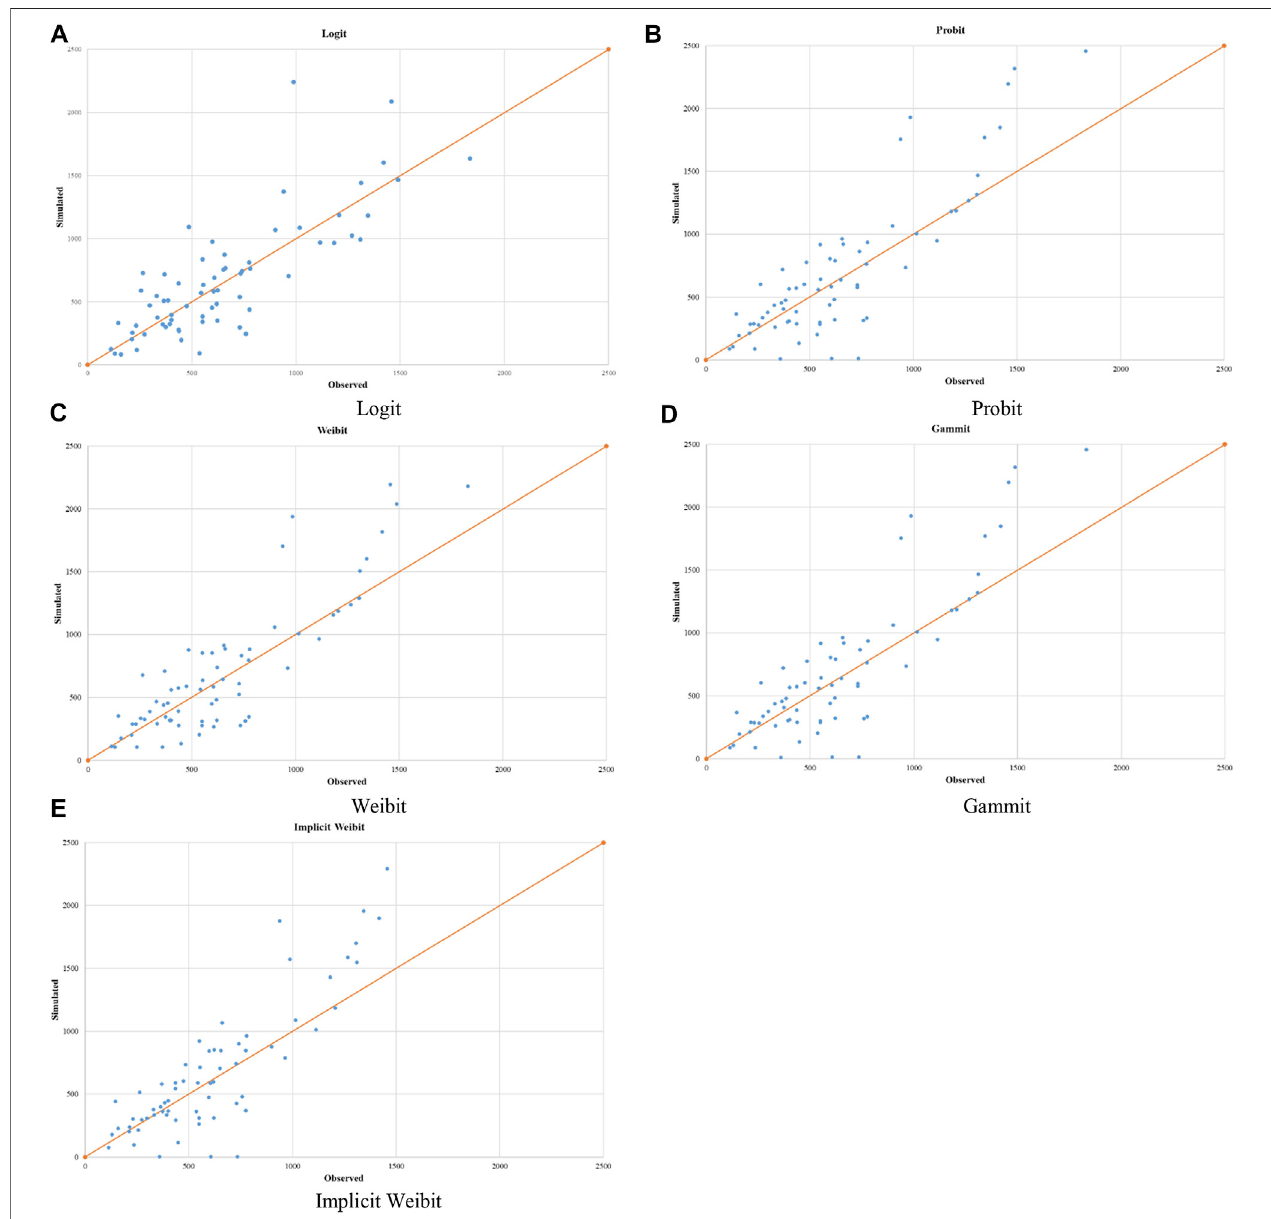
FIGURE 8 | Comparison of link fl ows: observed vs. simulated. (A) Logit (B) Probit (C) Weibit (D) Gammit (E) Implicit Weibit.